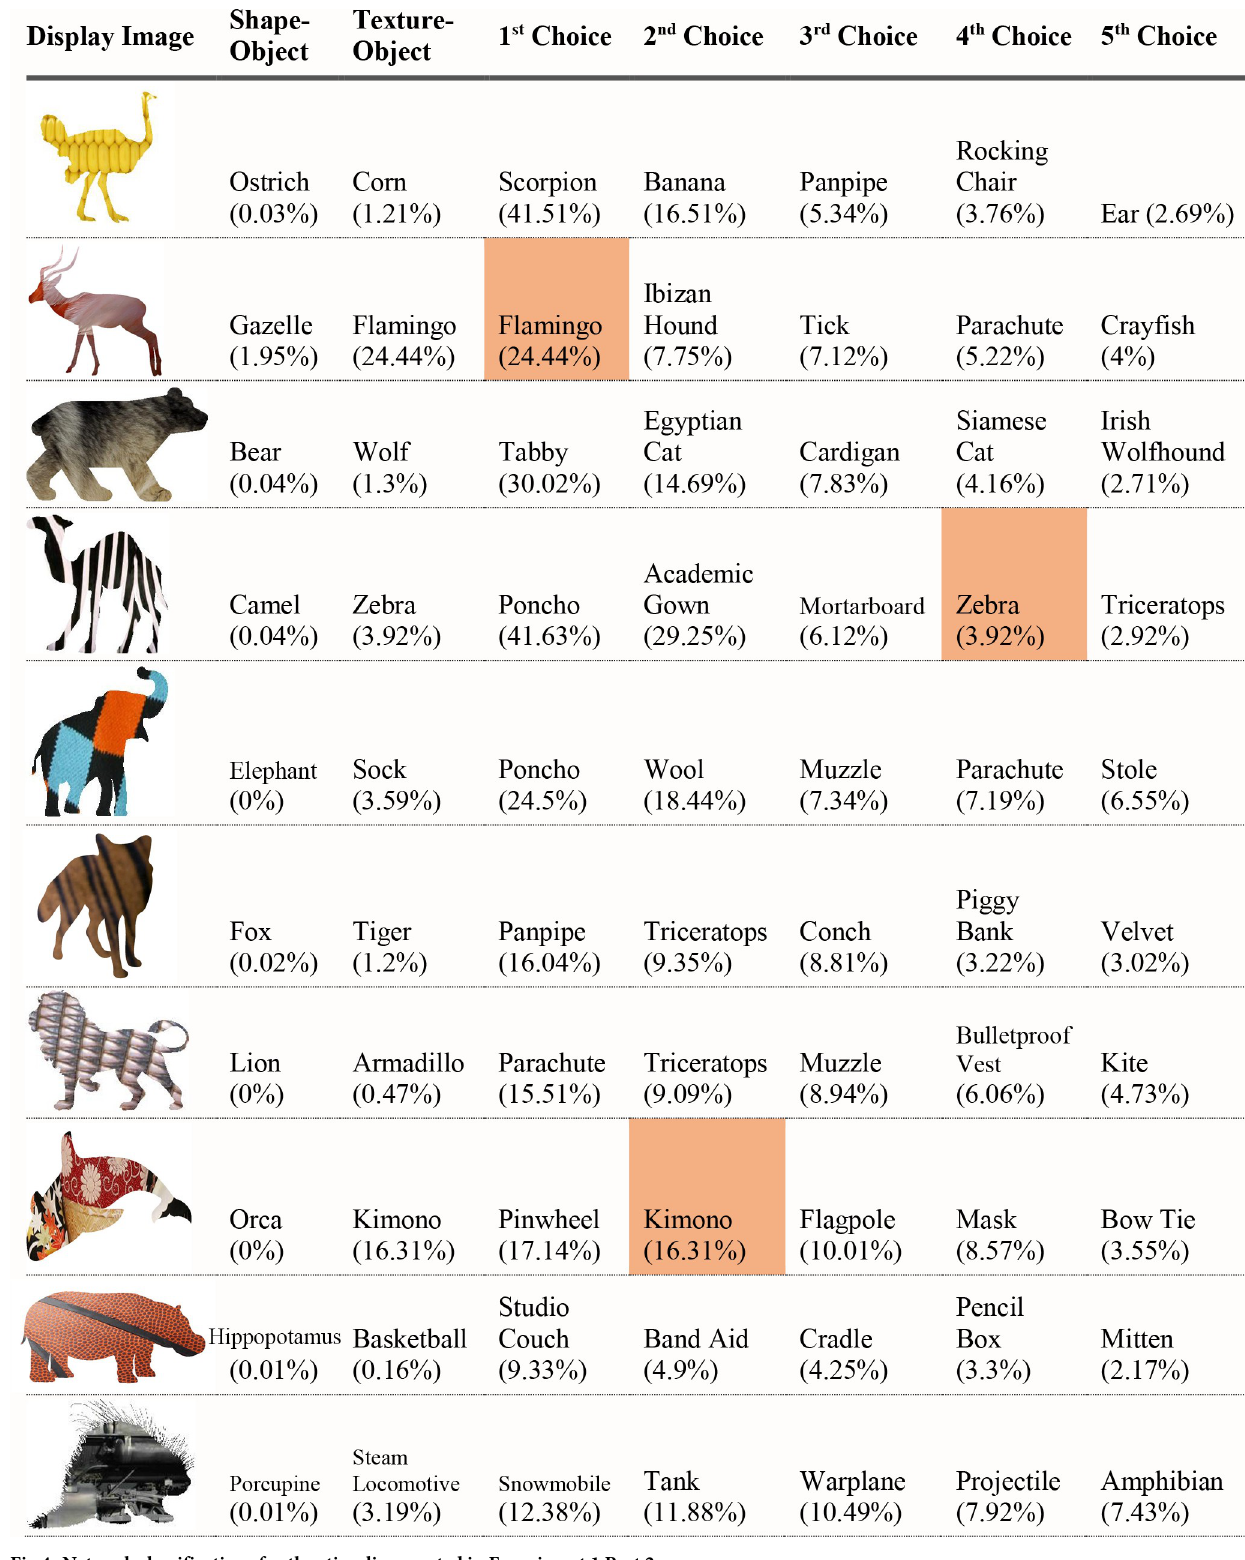
PLOS Computational Biology | https://doi.org/10.1371/journal.pcbi.1006613 December 7,